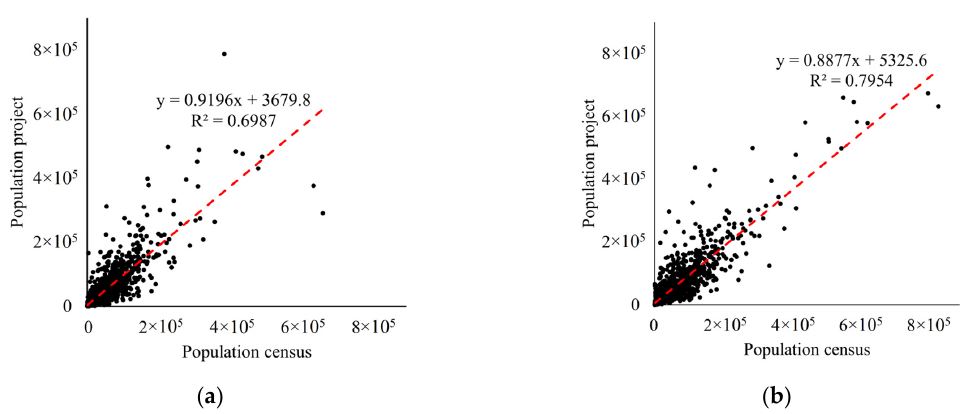
Figure 4. Validation results of the spatialization method in the years 2010 ( a ) and 2020 ( b ).